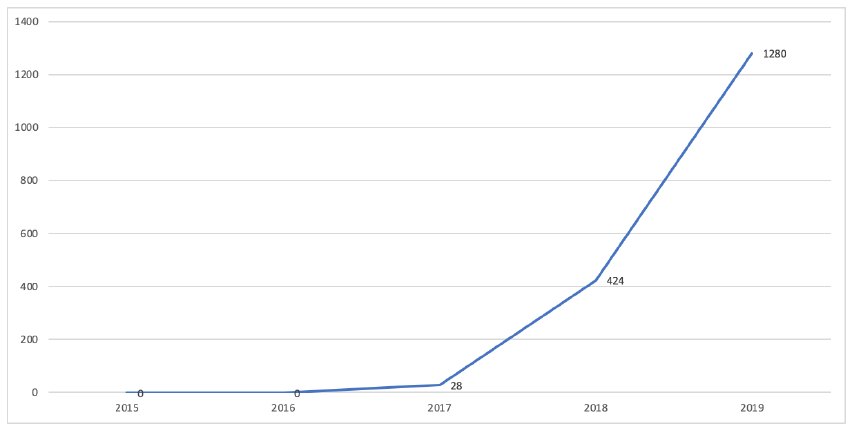
Figure 4. Number of citations on blockchain and the transport sector over the